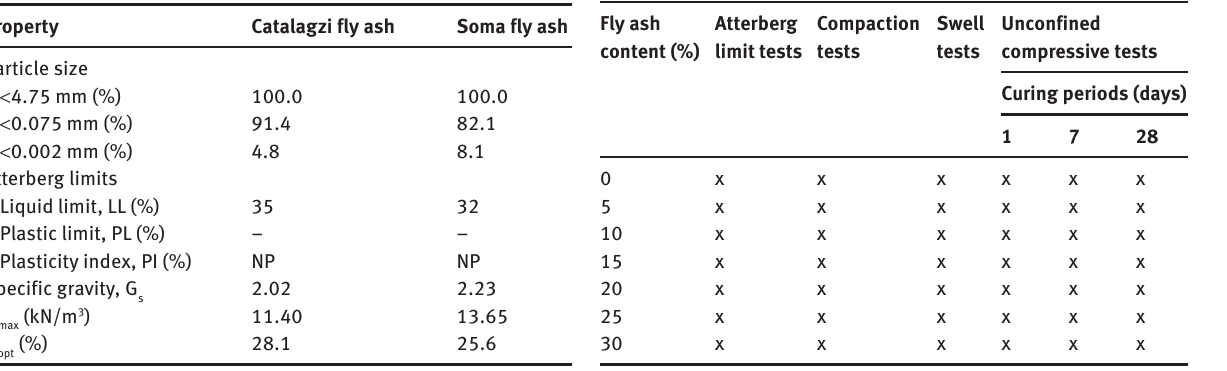
Table 4: Details of experimental